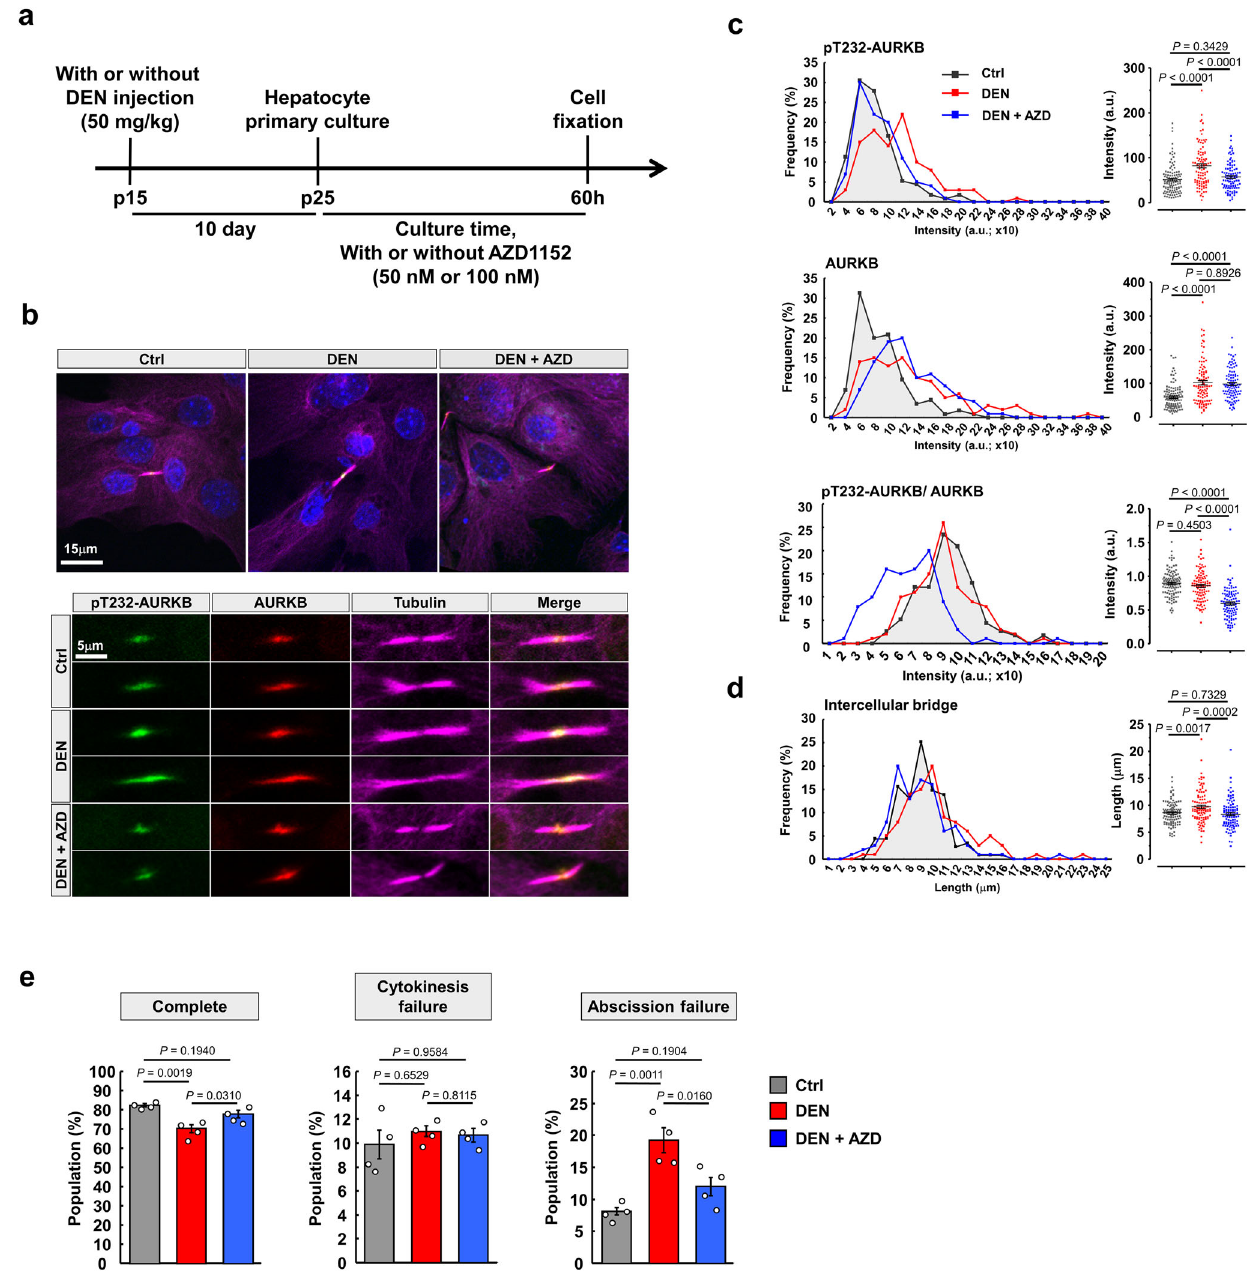
Fig. 5 Hyperactivation of AURKB mediates DEN-induced abscission failure. a Schema for detection of AURKB and pT232-AURKB in hepatocyte primary culture: Injection of normal saline or DEN at p15 followed by mice sacri fi ce at p25 for primary culture. Cultured hepatocytes were treated with AZD1152 or equal amount DMSO. b Immuno fl uorescence of pT232-AURKB and AURKB during abscission in indicated cultured hepatocytes with or without 50 nM AZD1152 treatment. The morphology of nuclei and intercellular bridges were outline by counterstaining with tubulin and DAPI, respectively. High magni fi cation shows the detailed structure of the midbodies. c , d Quanti fi cation of the intensity of pT232-AURKB, AURKB, and AURKB normalized pT232- AURKB at the midbody from ( b ). The length of intercellular bridge was quanti fi ed by analyzed the highly condensed tubulin signal between daughter cells. n = 115, 100, and 100 dividing hepatocytes at abscission stage, respectively, per group from three independent experiments. e Quanti fi cation of the abscission failure ratio in the indicated cultured hepatocytes from time-lapse images. n > 500 dividing hepatocytes/group, four independent experiments/ group. Statistic: one-way ANOVA ( c – e ). Values represent the mean ± SEM (also see Supplementary Fig.